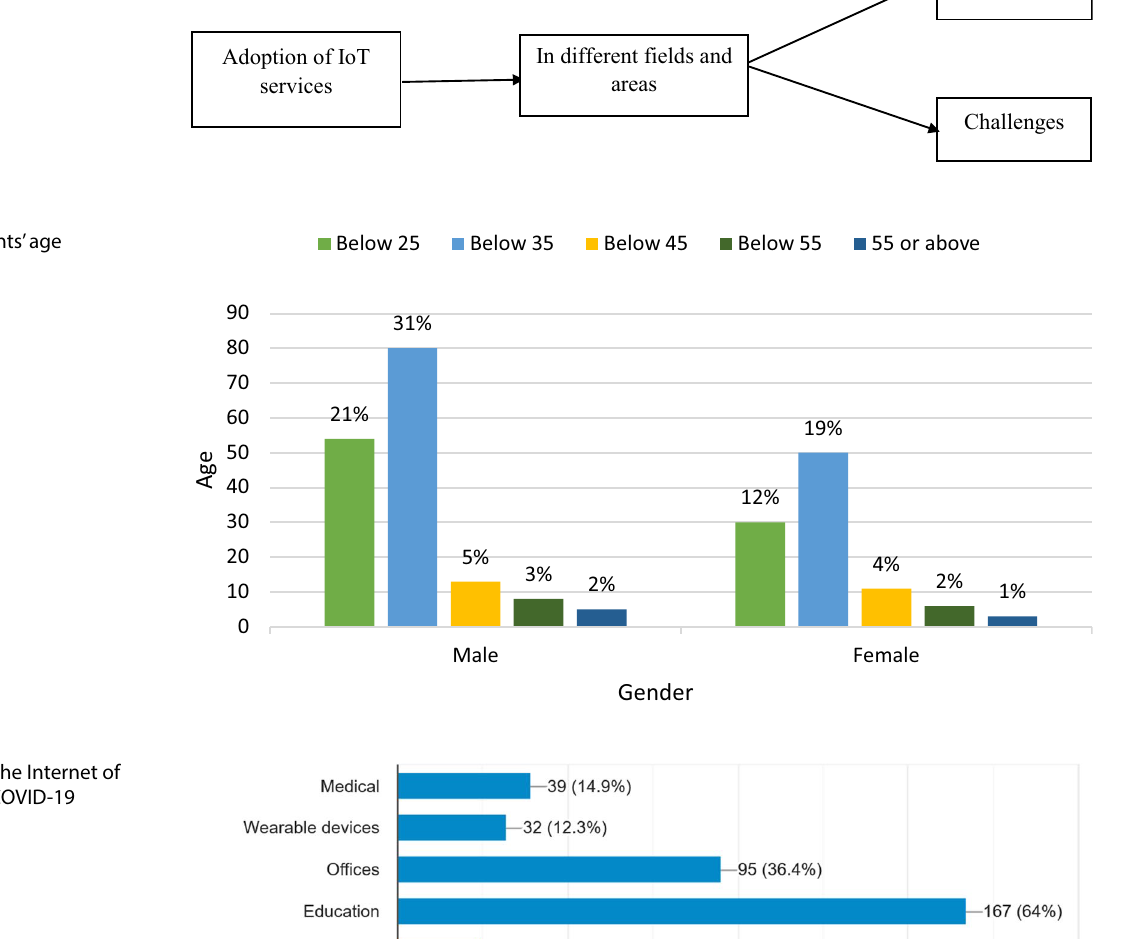
Fig. 8 Kind of IoT service